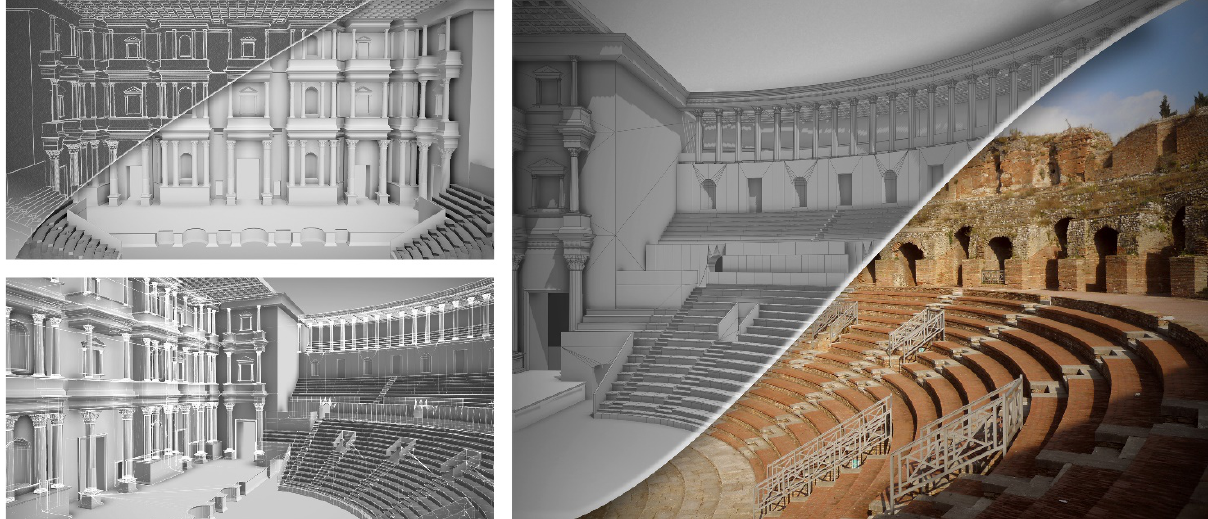
Figur e 12: Discretization of the 3d model e matching between material and virtual